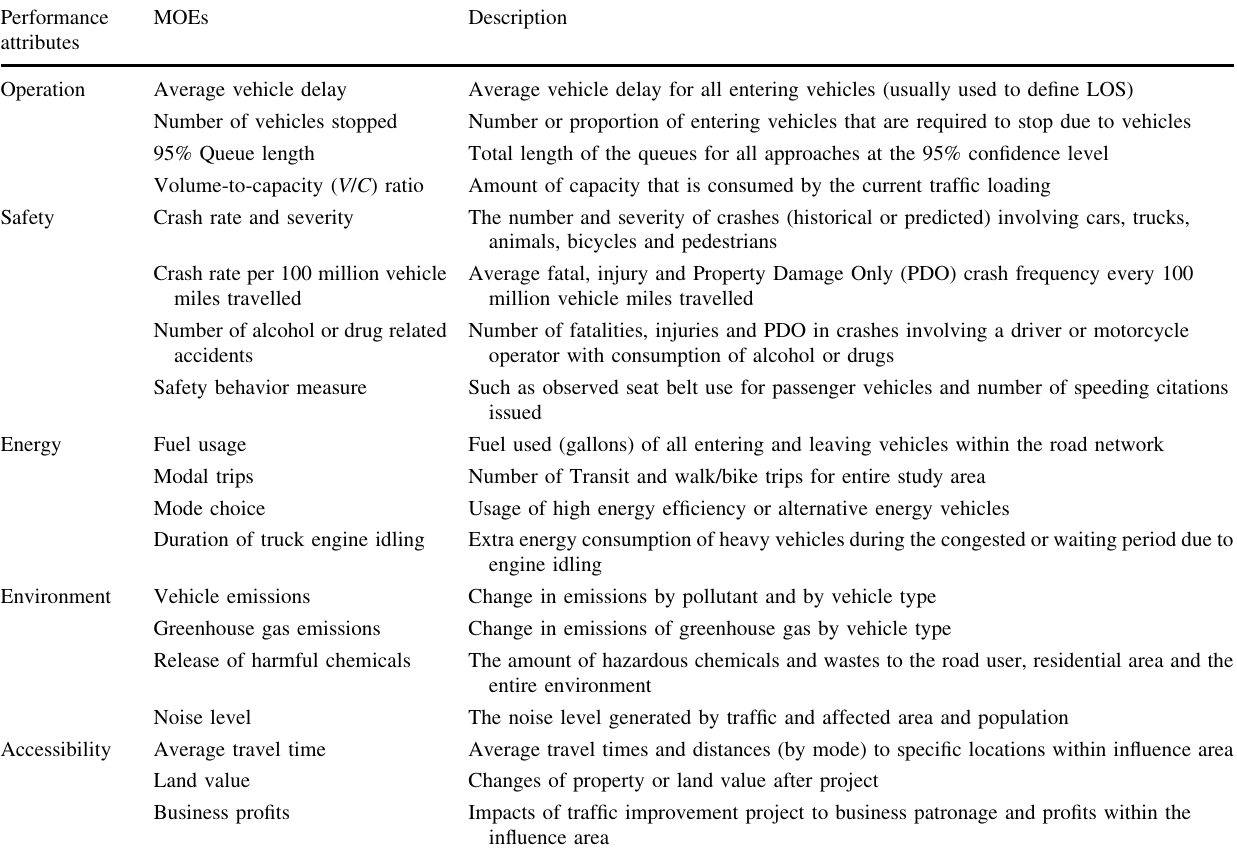
Table 1 Performance attributes and corresponding MOEs Performance